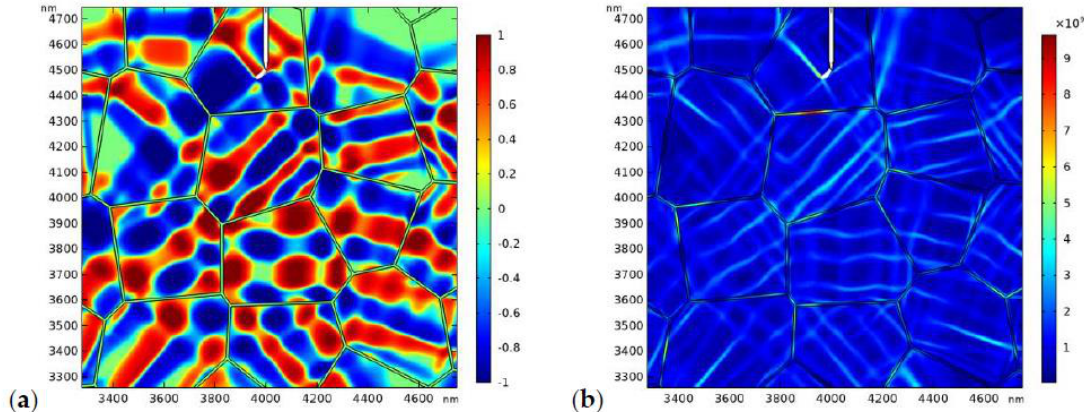
Figure 11. The local phase pattern ( a ) and the local von Mises stress field ( b ) before the microcrack nucleation (corresponding to Figure 10b).